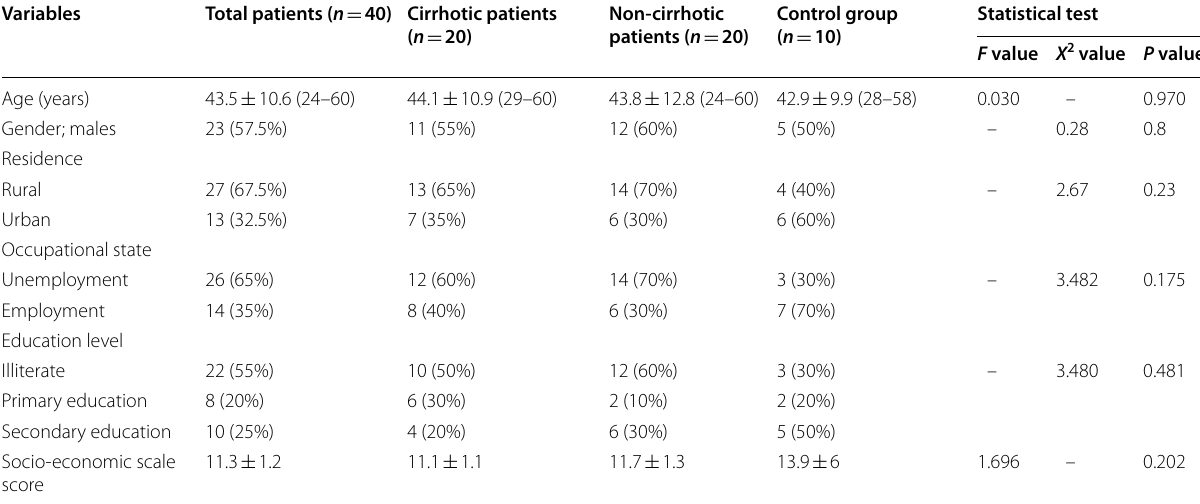
Values are presented as mean standard deviation or n (%). F -value for ANOVA, X 2 -value for Chi-square test. P -value < 0.05 is significant ±